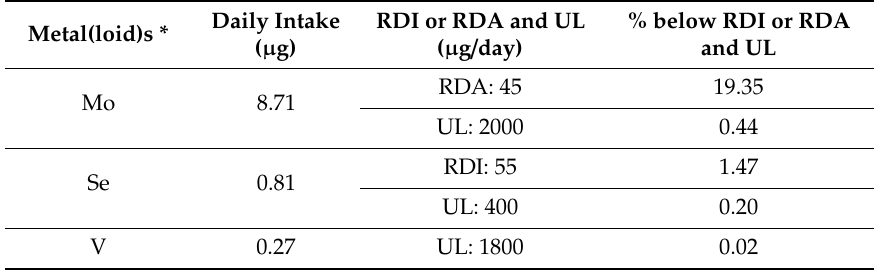
Table 4. Summary of the dietary exposure to metal(loid)s from 1.54 days per week of tea consumption relative to the RDI or RDA and